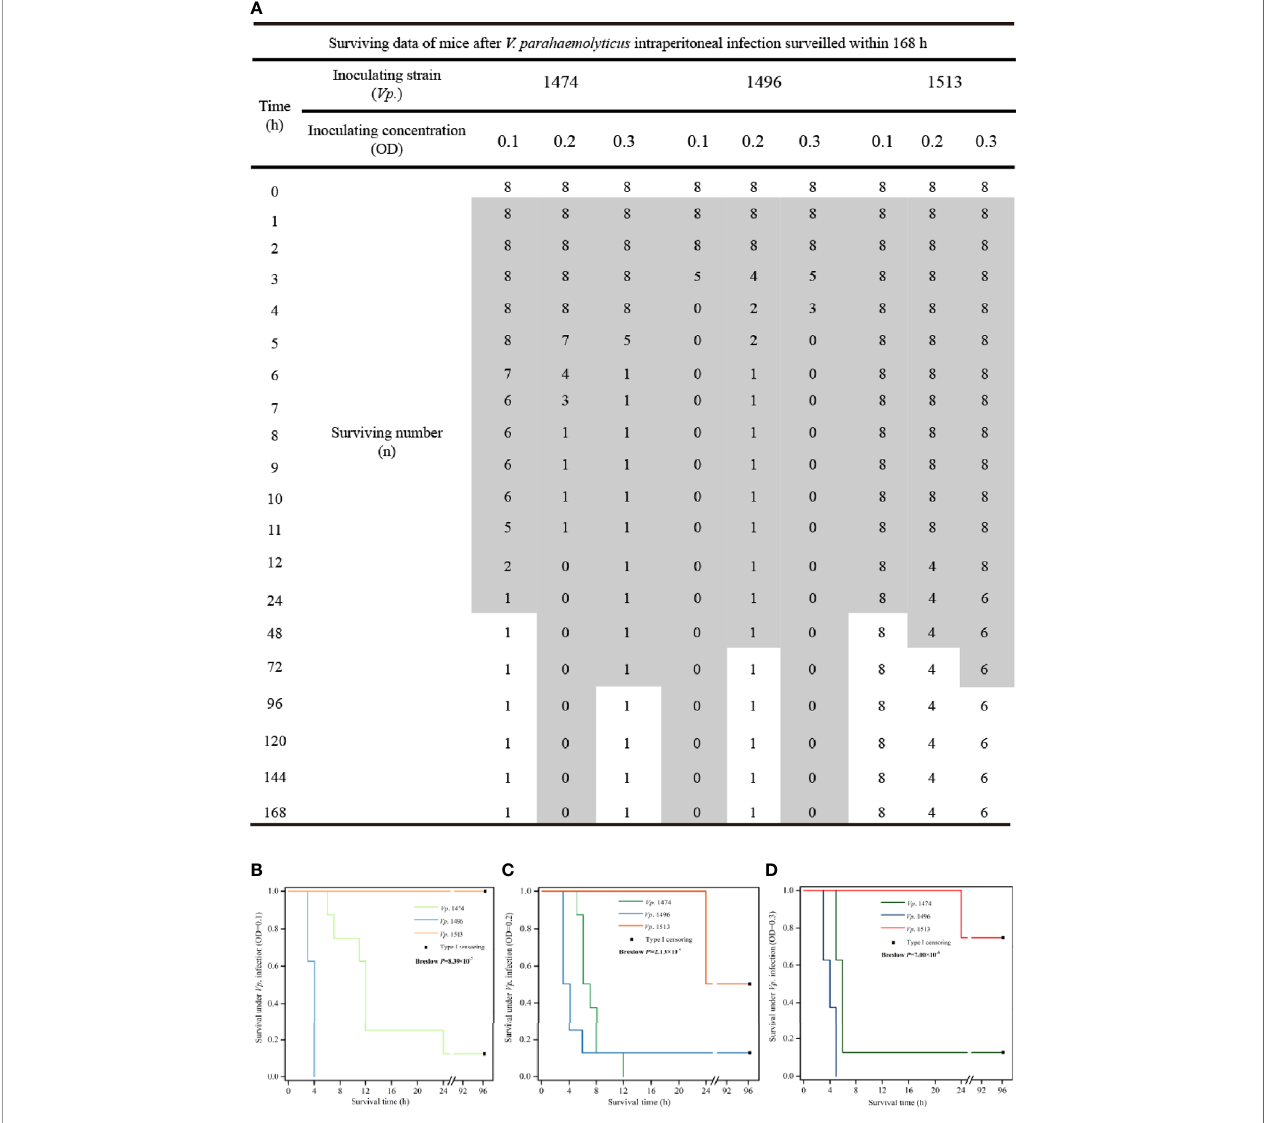
FIGURE 8 | V. parahaemolyticus in vivo infection and data statistics. (A) Operation of in vivo infection and data presentation. Suspension cultures of the selected strains, viz., Vp . 1474, Vp . 1496, and Vp . 1513, were adjusted to optical densities (OD) of 0.1, 0.2, and 0.3, and intraperitoneally injected into each group (9 groups, 8 mice per group). (B) Survival analysis of mice infected with V. parahaemolyticus under low concentration of injection (OD=0.1). (C) Survival analysis of mice infected with V. parahaemolyticus under moderate concentration of injection (OD=0.2). (D) Survival analysis of mice infected with V. parahaemolyticus under high concentration of injection (OD=0.3). Grey patch: the surviving mice that were observed in a poor living condition. The survival rate was updated every hour in acute infection period ( ≤ 12 h), and subsequently updated every 12 h in infection recovery period. The experiment continued for 4